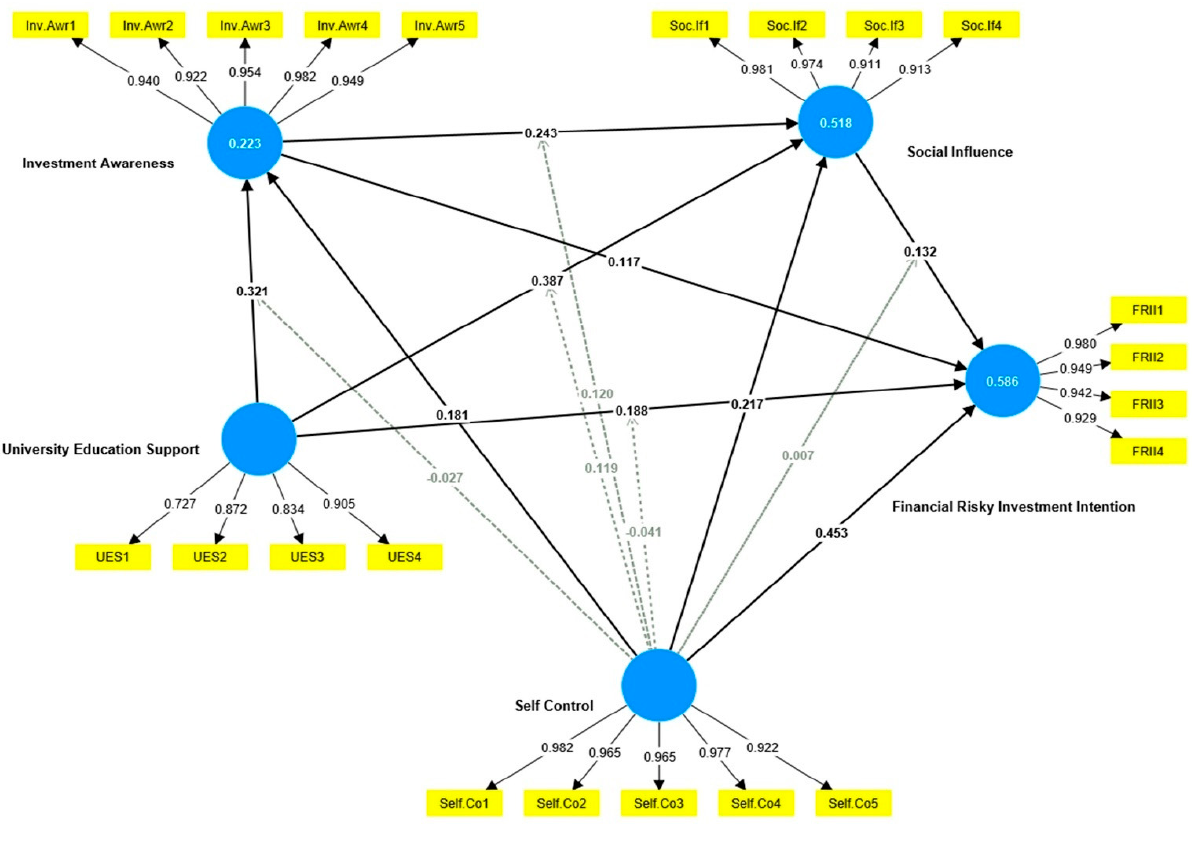
Figure 2. The study tested model.